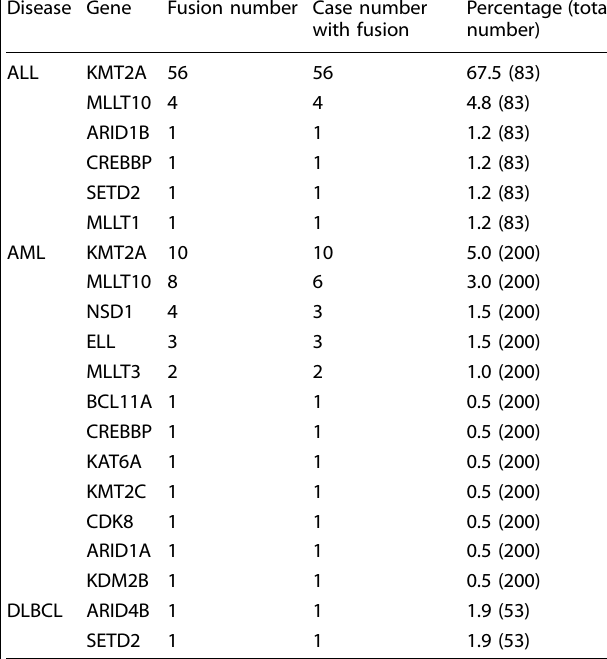
Table 3. Transcriptional cofactors with abnormal gene fusions in hematological malignancies Disease Gene